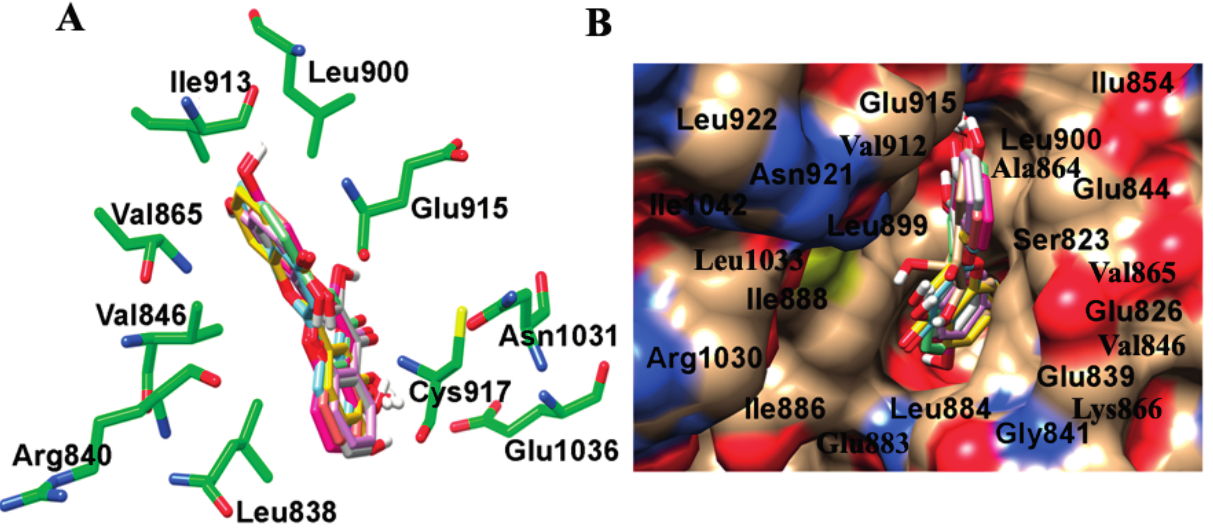
Figure 3. Molecular modelling showing interaction of 7,8-DHF derivatives with the VEGFR2. ( A ) Amino acid interactions of VEGFR2 (green) with the stick model of 7,8-DHF derivatives (red, blue, yellow, cyan, pink and orange); ( B ) Space filled surface view model to depict the binding pocket of 7,8-DHF derivatives (stick model) in VEGFR2 (color by